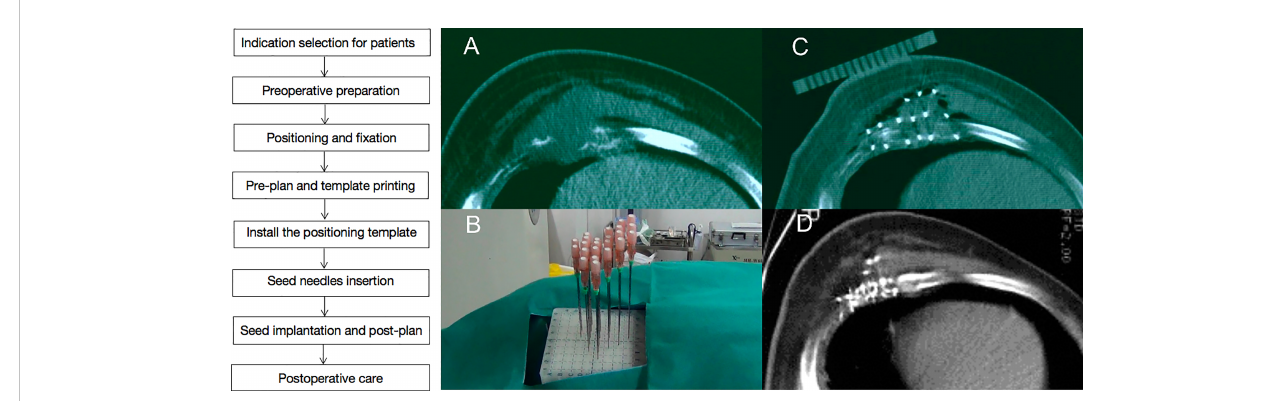
FIGURE 1 A case of recurrent chest wall cancer (rCWC) following surgery and adjuvant radiotherapy. (A) CT images of rCWC; (B) template-assisted CT-guided puncture the tumor target area; (C) 125 I seeds were implanted as a salvage treatment; and (D) 3 months after the seed implantation, partial response was